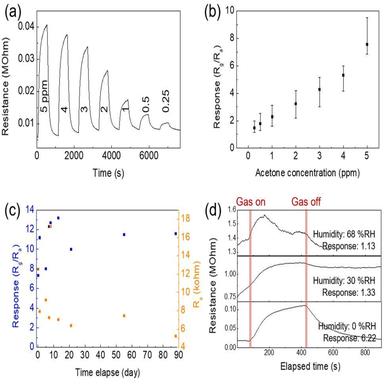
Sensing characteristics of gas sensors based on heterostructure (3:1) at 150 ◦C: (a) Resistance changes upon input of acetone gas of various concentrations, (b) responses at each acetone concentration, (c) responses toward 5 ppm of acetone gas and baseline resistances as a function of elapsed time, and (d) resistance changes upon input of acetone gas in various humid atmosphere levels of 0%, 30%, and 68%RH.